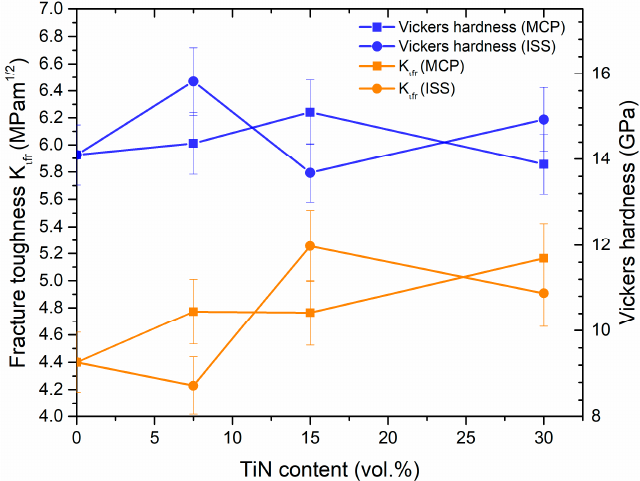
Figure 5. Indentation toughness and Vickers hardness as a function of the TiN content of the SP-sintered (1300 °C, 5 min, 50 MPa) composites fabricated by the ISS and MCP routes.